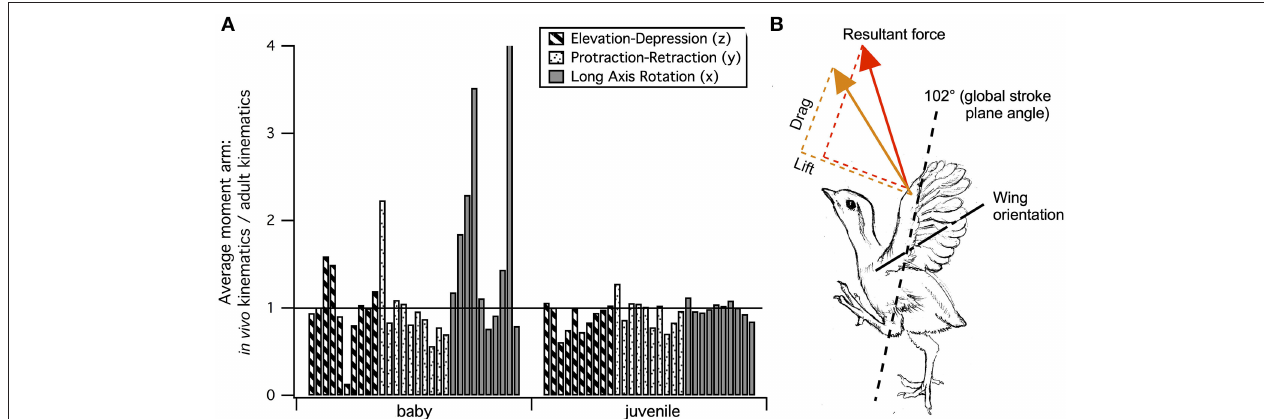
FIGURE 8 | Kinematic optimization? In spite of changes in skeletal morphology, flapping kinematics during maximal effort wing-assisted incline running (WAIR) are very similar in immature and adult chukars (Heers et al., 2016). (A) Differences that do exist may help improve muscle leverage for long axis rotation in baby birds ( Figure 7 ), whose humeri lack the exaggerated muscle attachment sites of adults ( Figures 2 , 5 ) (7 out of 10 muscles have greater leverage for long axis rotation during in vivo than adult kinematics, compared to 4 out of 10 for elevation/depression and 3 out of 10 for protraction/retraction). In juveniles, muscle leverage for long axis rotation during in vivo and adult kinematics is more similar (5 out of 10 muscles have greater leverage for long axis rotation during in vivo than adult kinematics, but differences are not as substantial; 4 out of 10 are greater for elevation/depression and 5 out of 10 are greater for protraction/retraction). (B) Kinematic differences may also improve wing performance: 8 (red arrow) and 10 (orange arrow) day old chukars have a more vertical global stroke plane angle than older birds, which helps compensate for their draggy wings by orienting drag in a direction that contributes substantially to weight support (Jackson et al., 2009; Heers et al., 2011). (A) Each bar represents the average moment arm of one muscle during in vivo kinematics divided by its average moment arm during adult kinematics; pectoralis and supracoracoideus are the first and second bars, respectively, for each grouping. (B) Adapted from Heers et al. (2011); sketch by Robert